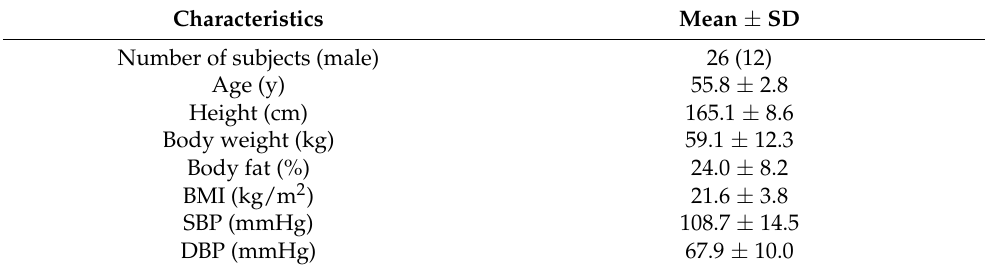
Table 2. Participant